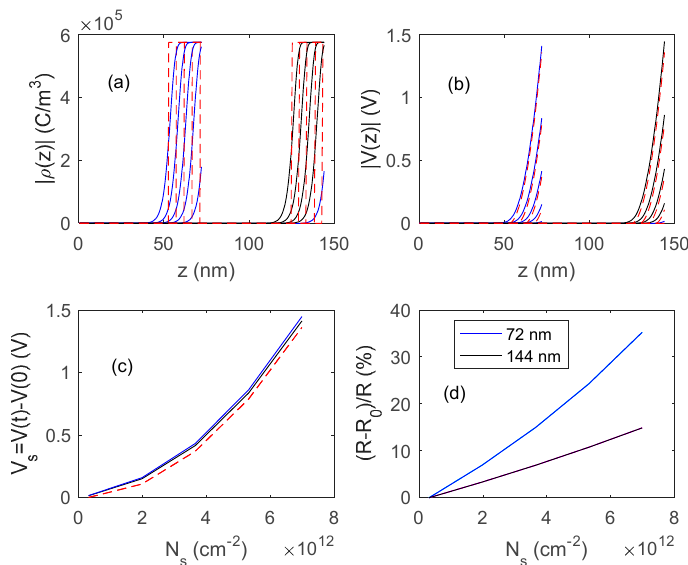
Figure 16. Distribution of the charge density, ρ (plot ( a )) and of the voltage (plot ( b )) inside the film as a function of z for different values of charged surface species density, N s , for two films thickness, 72 nm and 144 nm. N s in the range (0.3 × 10 12 cm − 2 –7.2 × 10 12 cm − 2 ). ( c ) Surface voltage barrier as a function of the density of charged surface species. Solid lines: proposed model, dashed lines: fully depleted model. ( d ) Sensor responses to variation of surface charge density. Data for In 2 O 3 are taken from [28,29] N d = 3.6 × 10 18 cm − 3